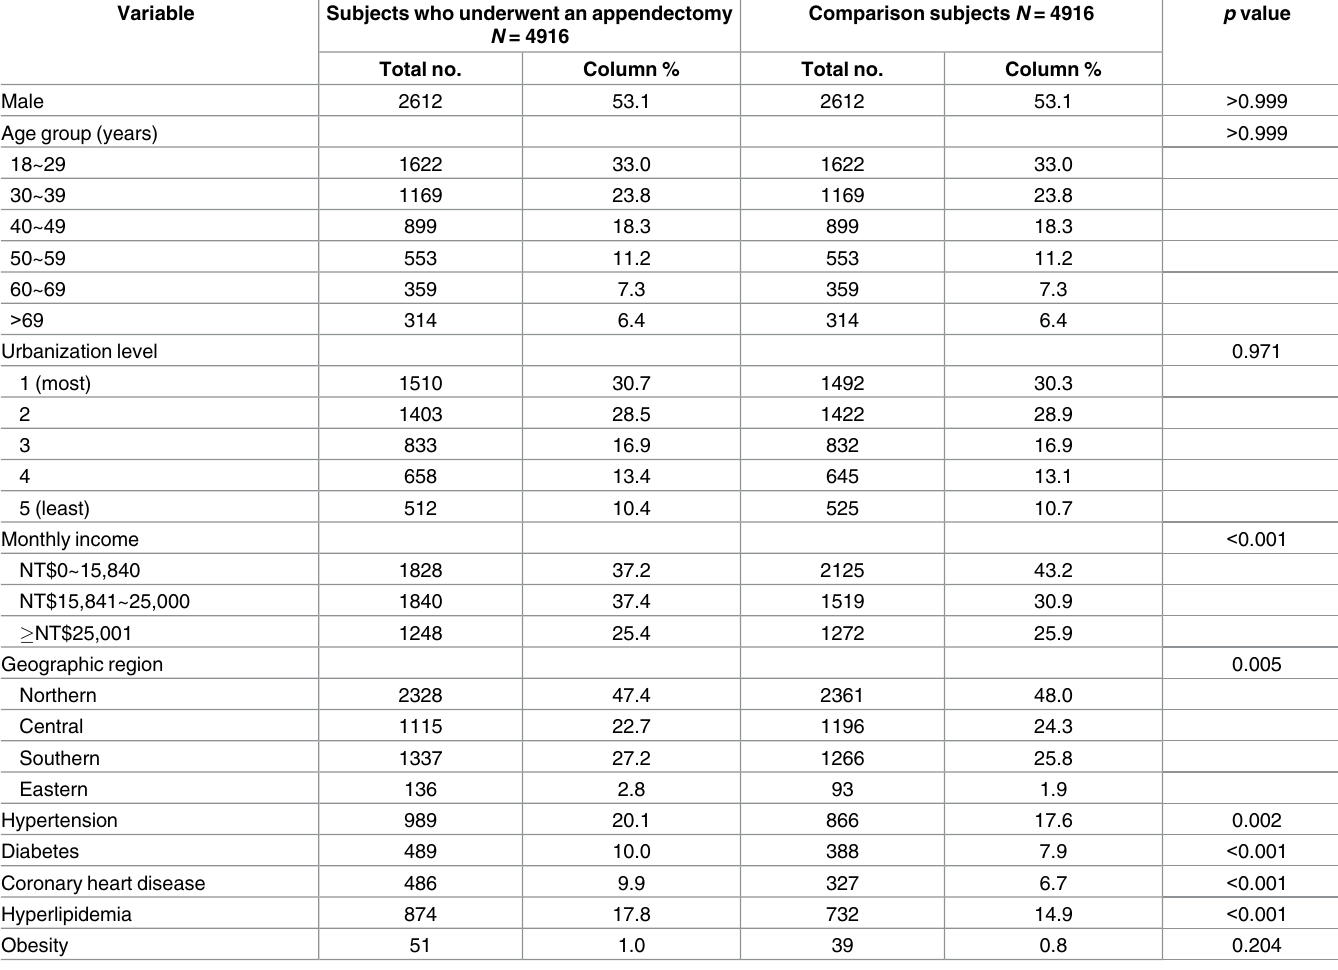
Table 1. Demographic and clinical characteristics of sampled subjects (N =